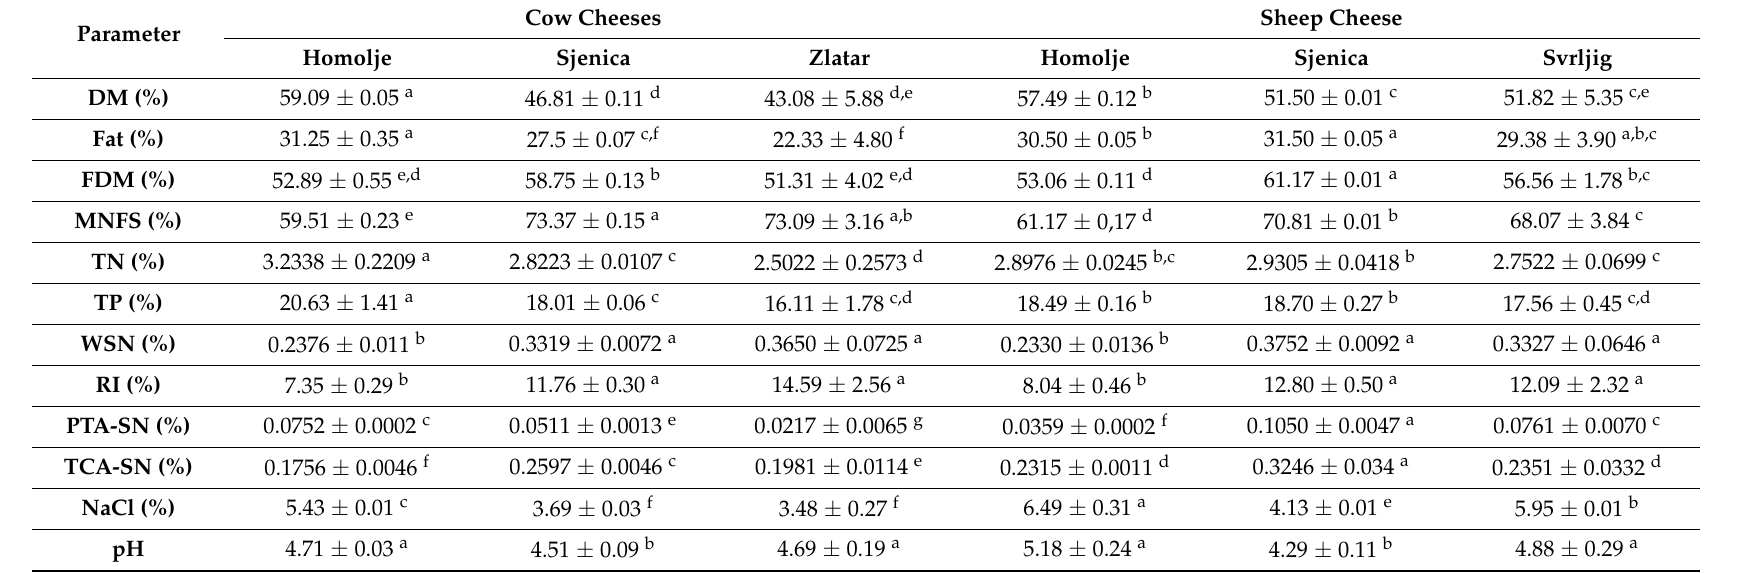
Table 1. The chemical composition and ripening parameters of traditional Serbian white cheeses